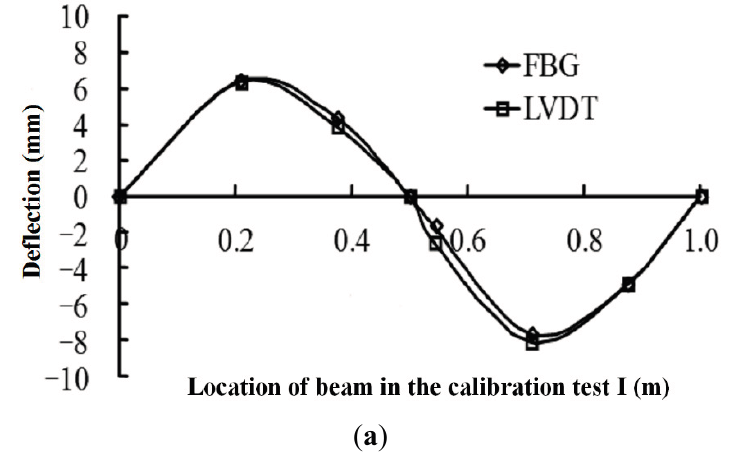
Figure 4. Installment of FBG and LVDT sensors in the deflection test of FBG sensing bar.